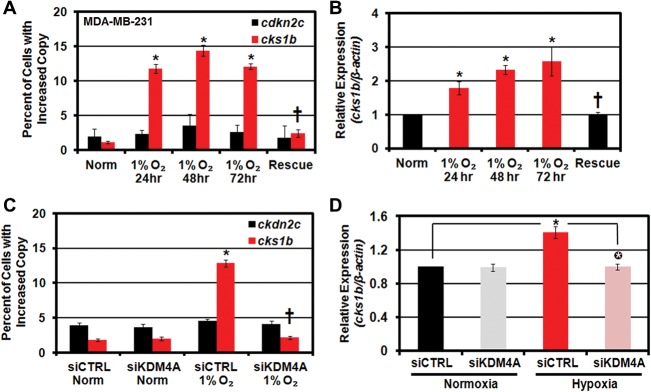
CKS1B exhibits site-specific copy gain and increased expression in hypoxic cells. (A,B) CKS1B is copy-gained and overexpressed in hypoxic breast cancer cell lines. Quantification of FISH (A) and CKS1B mRNA expression (B) in MDA-MB 231 cells maintained in hypoxia for 24–72 h or maintained in hypoxia for 48 h prior to return to normoxia for 24 h (rescue). (†) Significant difference from 1% O2 at 24 h by two-tailed Student's t-test. P < 0.05. (C) Hypoxia-dependent CKS1B copy gain requires KDM4A. Quantification of FISH for 1q12h and 8c for MDA-MB-231 cells maintained in normoxia or hypoxia with or without siRNA depletion of KDM4A. (†) Significant difference from 1% O2 siCTRL by two-tailed Student's t-test. (D) Hypoxia-dependent CKS1B transcript induction requires KDM4A. Circled asterisks indicate significant difference from siCTRL in hypoxia by two-tailed Student's t-test. P < 0.05. In all panels, asterisks indicate significant difference from normoxia by two-tailed Student's t-test. P < 0.05.